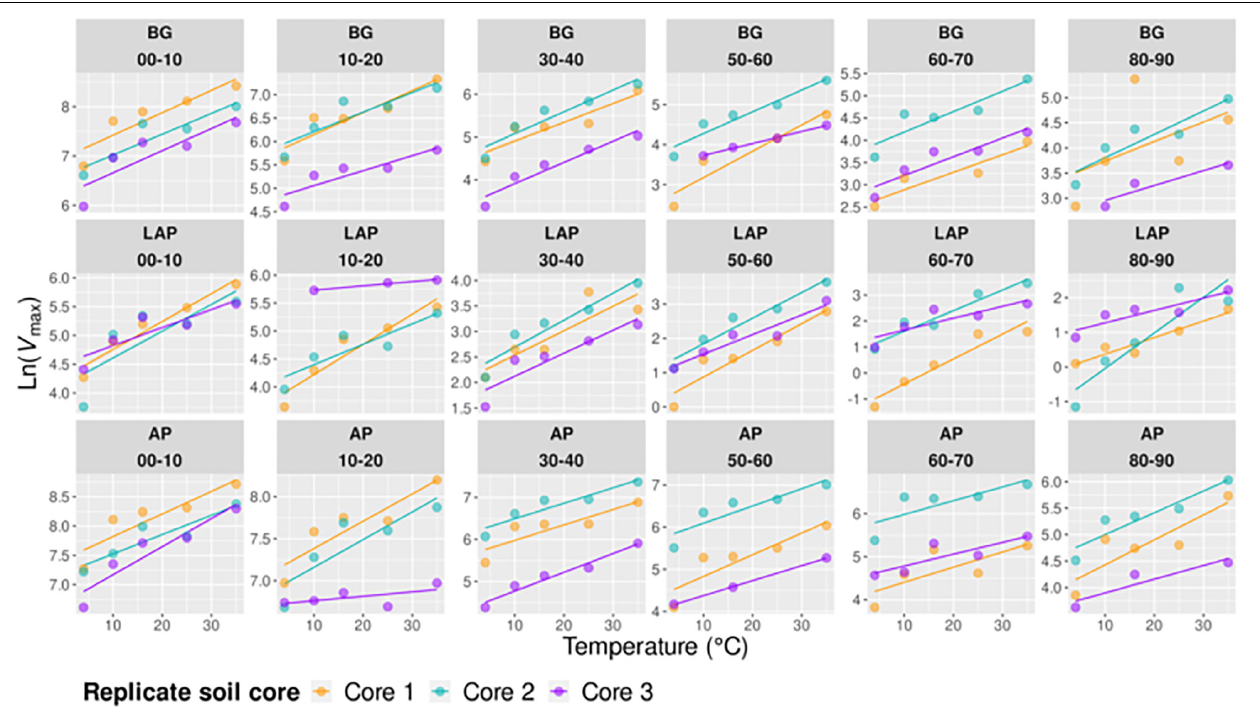
FIGURE 5 | Arrhenius models of V max over five temperatures from 4 to 35 ◦ C per enzyme, depth, and replicate core sample.